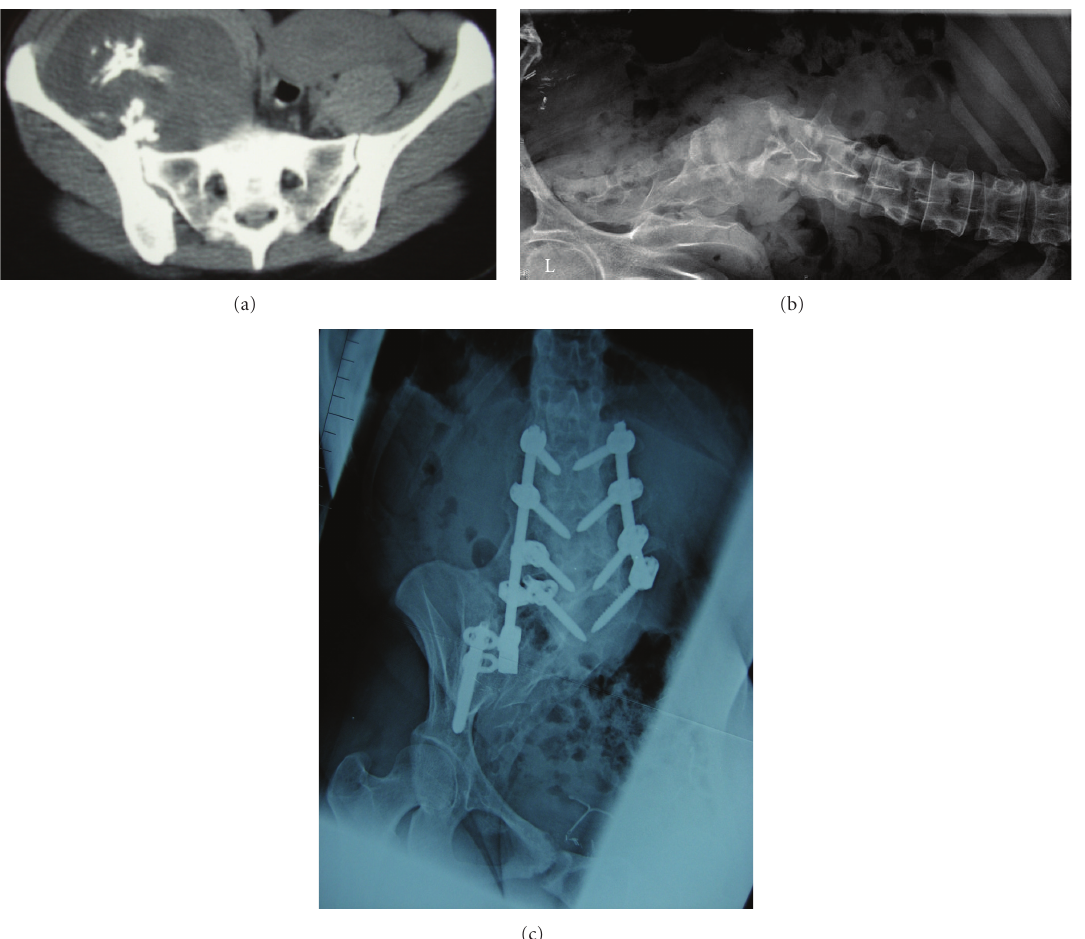
Figure 1: A 27-year-old female with a right sacroiliac secondary chondrosarcoma arising from a sacroiliac osteochondroma. The tumor involved half of the sacrum, and a sagittal resection through the midline of the sacrum was required to obtain wide margins. She developed scoliosis and sitting imbalance and underwent a subsequent posterior spinal fusion and instrumentation. She remains free of disease 48 months after